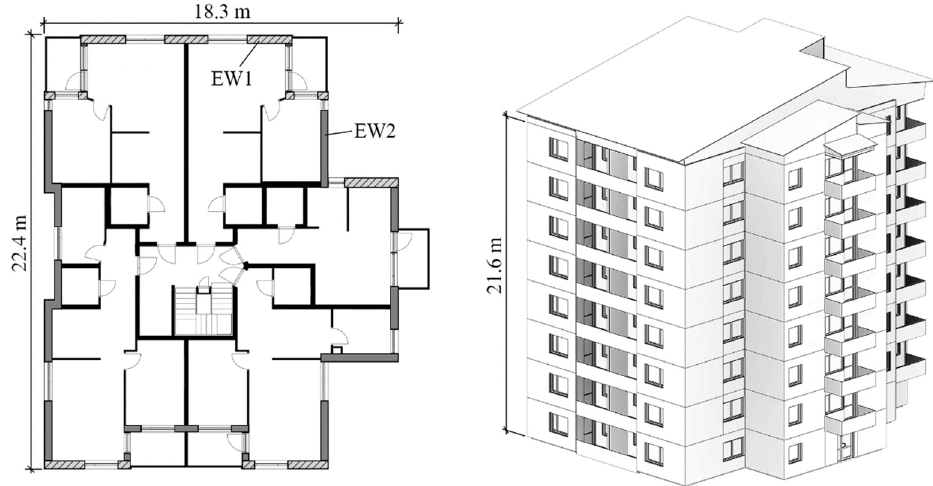
Figure 3. A plan view and 3D view of the high-rise apartment building.